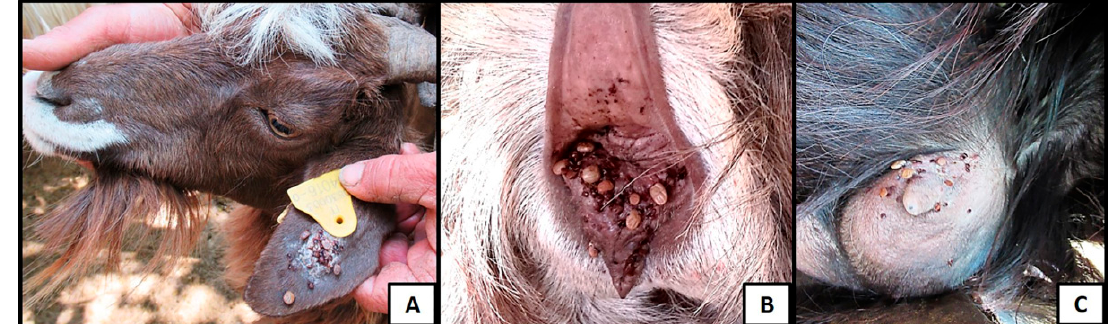
Figure 1. Tick infestations: ( A ) Ear lobe, ( B ) vulva, and ( C ) udder. All of the ticks were adults and were morphologically identified as Rhipicephalus bursa 84.8% (129/152), Rhipicephalus sanguineus 13.8% (21/152), Rhipicephalus turanicus 0.65% (1/152), and Rhipicephalus hylusitanium 0.65% (1/152) (Table 2). Table 2. Tick species and number collected from the three farms investigated. Farm Tick Species No. of Ticks Total A R. bursa 45 R. bursa B 41 R. turanicus R. bursa 66 R.